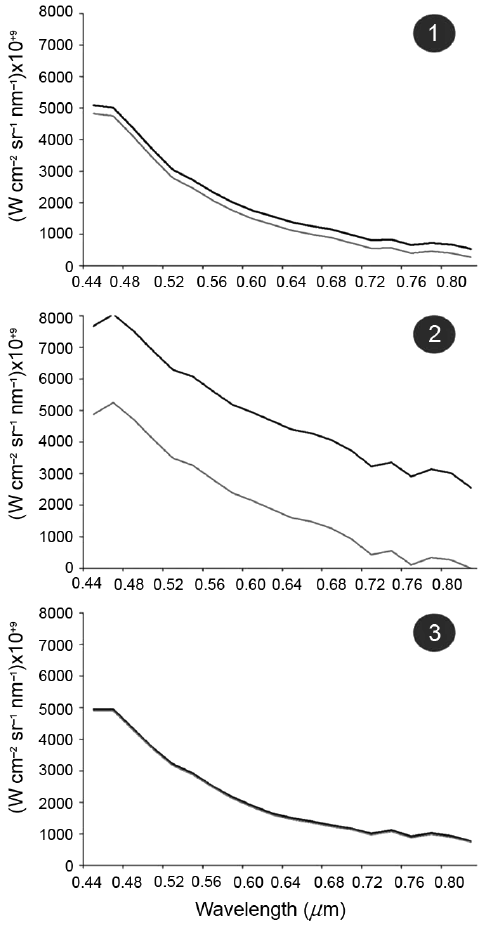
Fig. 8. Comparison between spectra before (in black) and after (in grey) the sun glint correction, rel- evant to three different pixels (showed in fig. 5 with point 1, 2 and 3) belonging to the same scan line (showed in red in fig. 5) selected in run3 and located out (point 1 and 3) and inside (point 2) the sun glit- ter